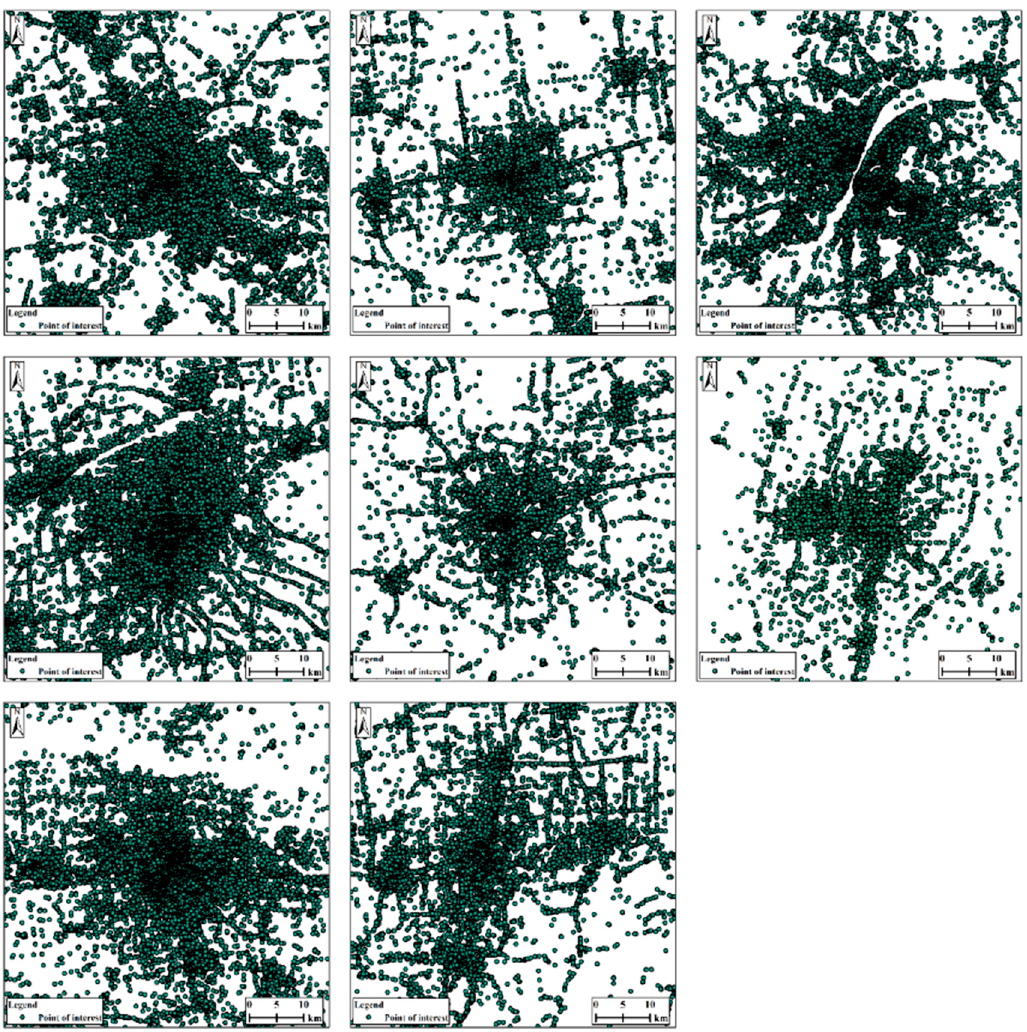
Figure A4. Map of the point of interest (POI) data for the 32 Chinese cities.